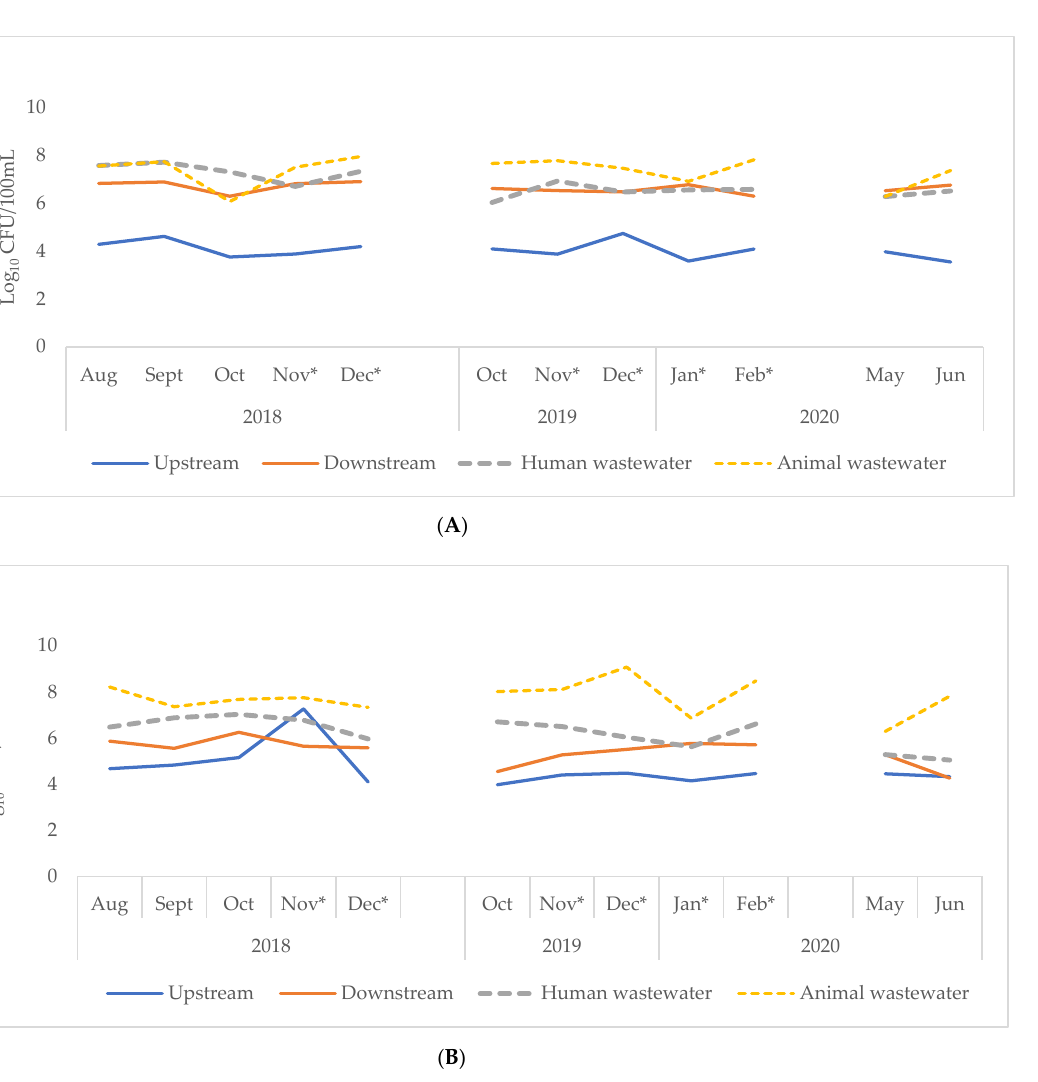
Figure 3. Log concentration of E. coli in sample sites of Accra ( A ) and Kasoa ( B ) for the periods: August 2018 – December